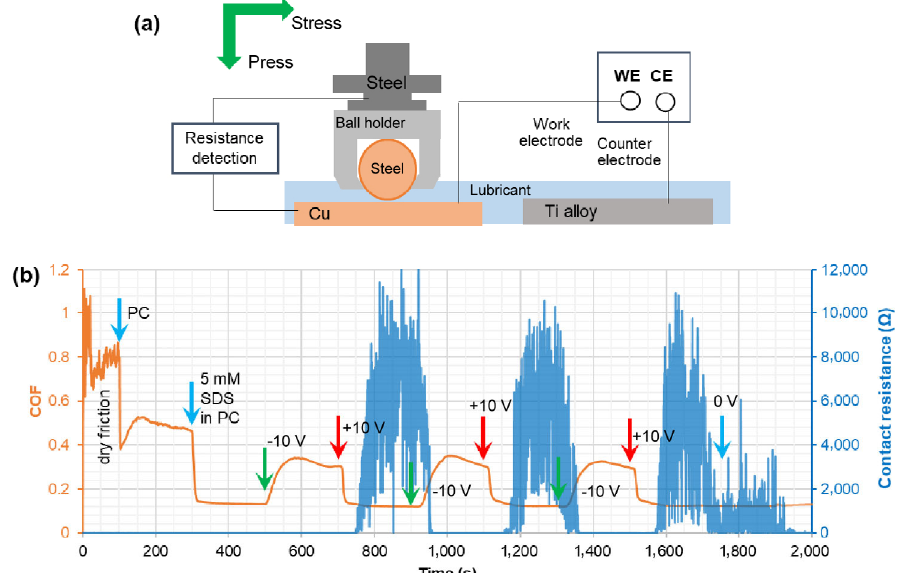
Fig. 11 (a) Schematic diagram of a tribometer combined with a two electrodes system and a contact resistance measuring instrument, (b) COF and contact resistance vs. time under different lubrication conditions and applied